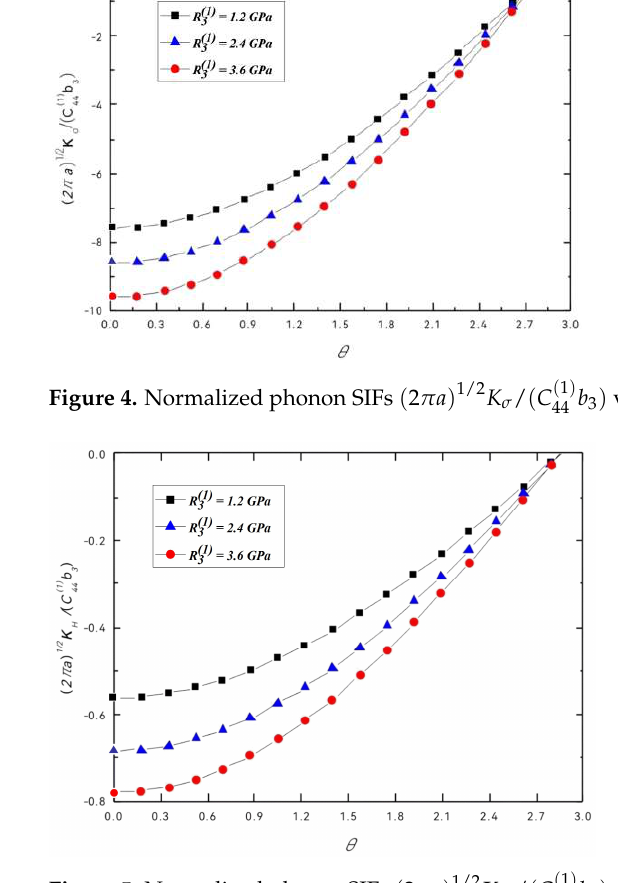
Figure 5. Normalized phason SIFs ( 2 π a ) 1/2 K H / ( C vs. .